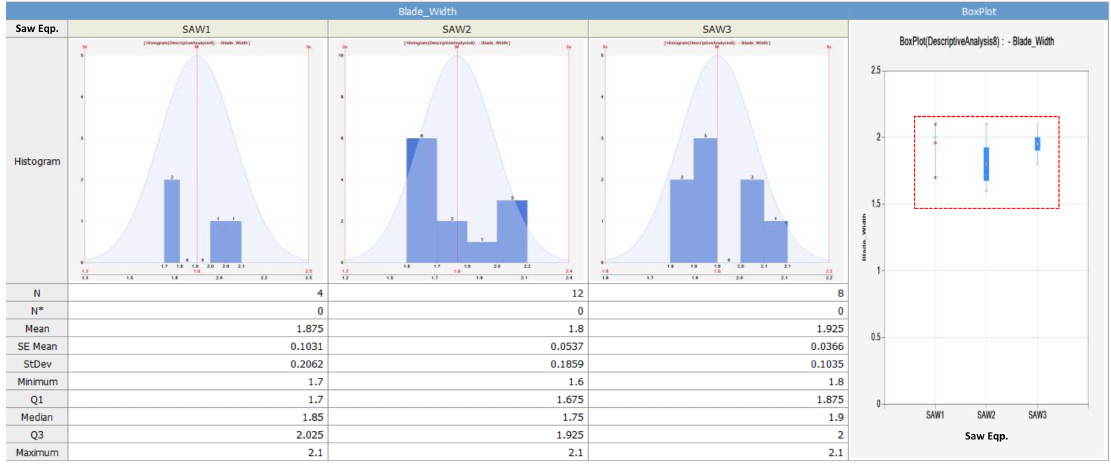
Figure 7. Analysis of di ff erence in the blade widths among the wafer sawing process